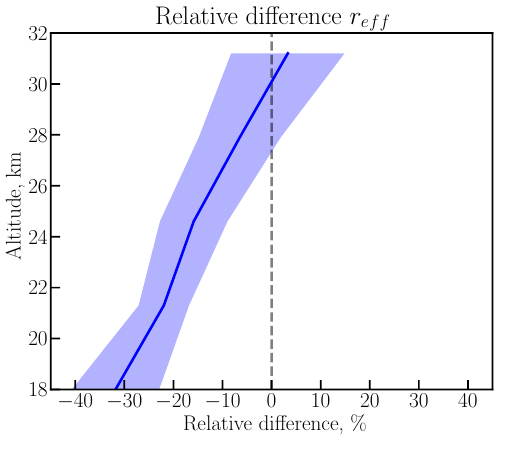
Figure 14. Mean relative difference ((SCIA- MACHY − SAGE II) / SAGE II) between effective radii from collocated SCIAMACHY and SAGE II measurements.